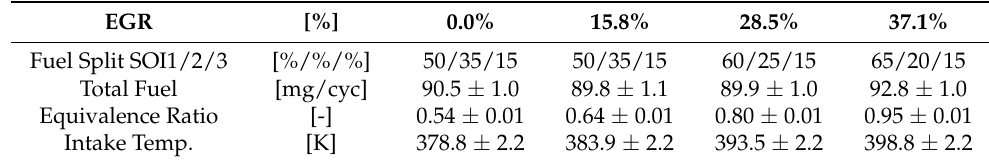
Table 4. Operating conditions of EGR sweep.